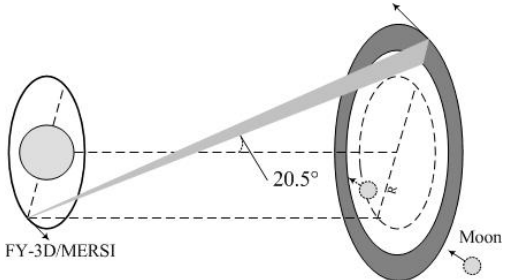
Figure 1. Schematic diagram of the geometric relationship between the moon and the FengYun 3D meteorological satellite (FY-3D) MEdium Resolution Spectral Imager (MERSI).